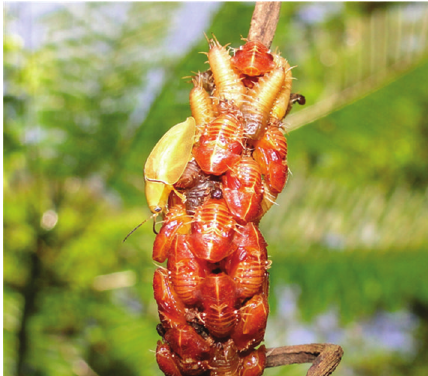
Figure 4: Imbricated pupae of Omaspides pallidipennis Boheman, 1854 in stem of its host plant Ipomoea alba L. (Convolvulaceae). A fragment of Atlantic Forest (Floresta Nacional de Passa Quatro, Minas Gerais State,